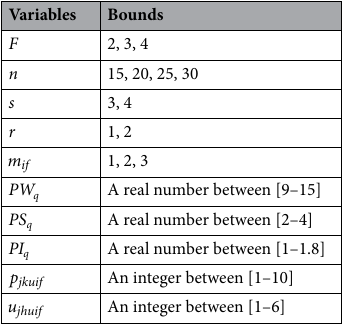
Table 5. Bounds of the variables.